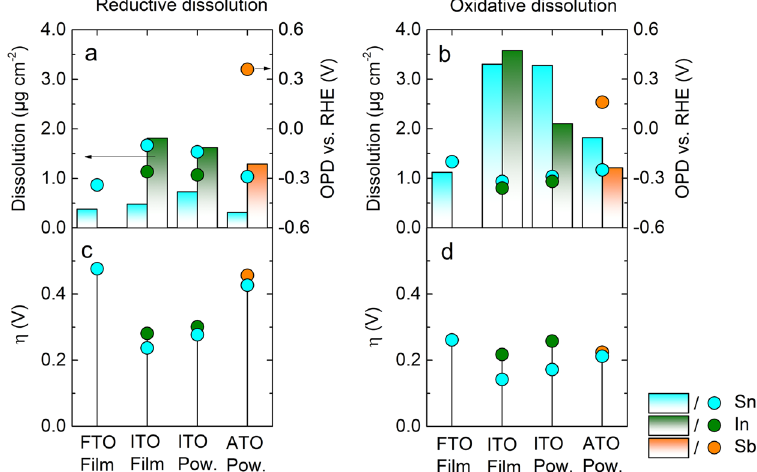
Figure 3. ( a , b ) Comparison of the integrated dissolution during reduction and reoxidation shown in bars. Values are normalized by the portion of the respective element in the material. Related onset potential of dissolution (OPD) is shown in bullets on the right axis. ( c,d ) Overpotential for the reductive and oxidative dissolution calculated from the difference between OPD and equilibrium potential at 1 nM (see equations